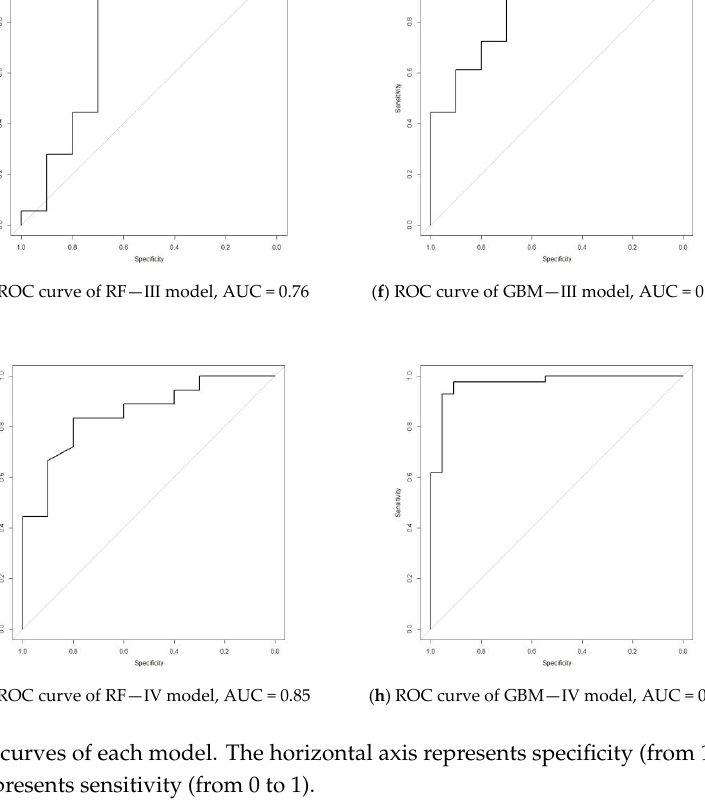
Table 4. Summary of model performances.